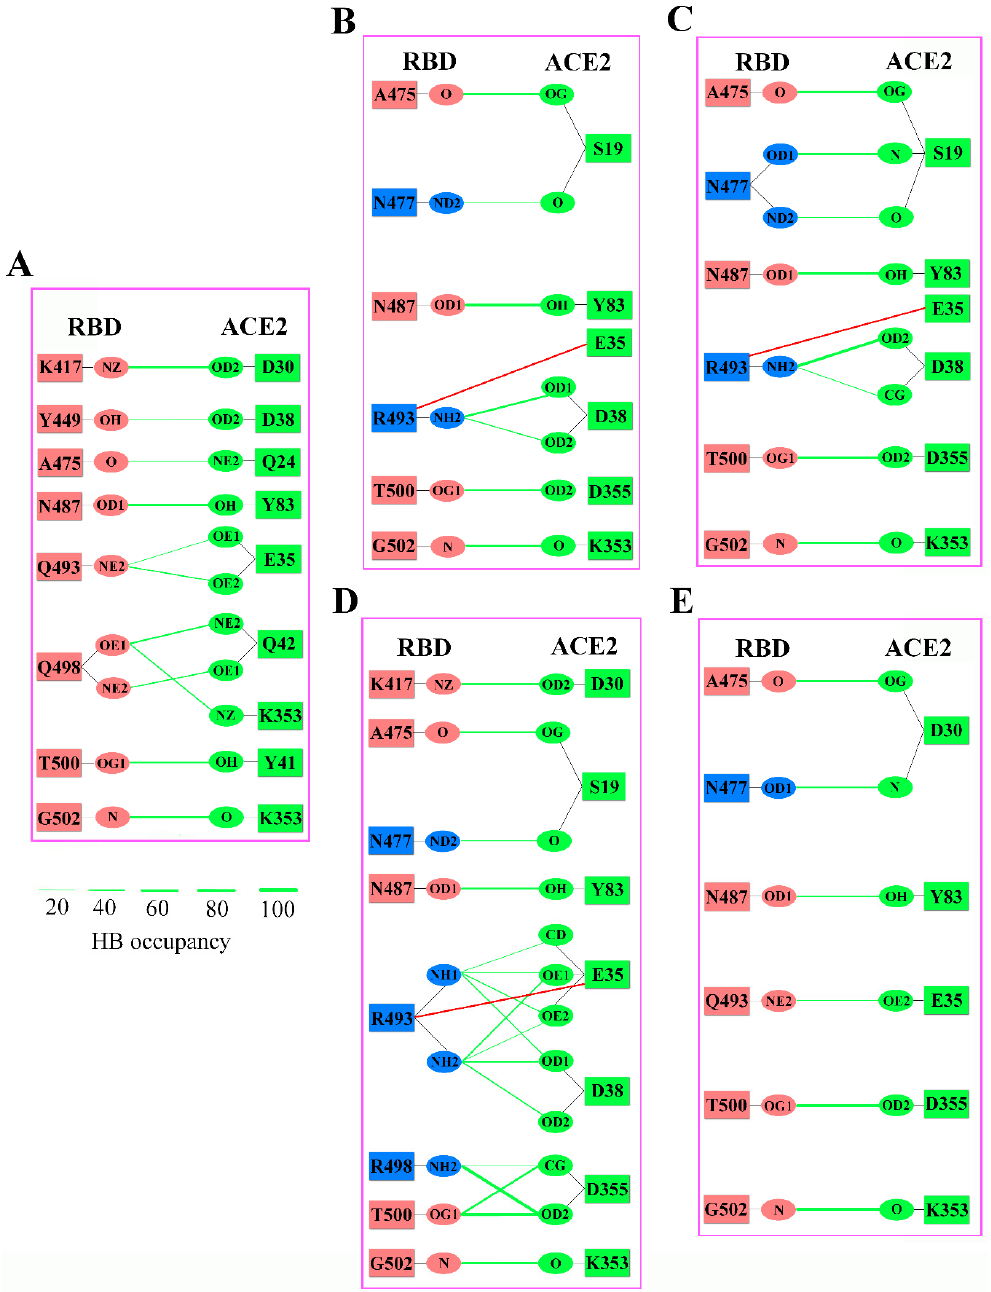
Figure 8. The hydrogen bond networks (HBNs) and salt bridges (SBs) across the binding interfaces of the RBD WT -ACE2 and RBD OMI s-ACE2 complexes. ( A ) RBD WT -ACE2. ( B ) RBD BA.1 -ACE2. ( C ) RBD BA.2 -ACE2. ( D ) RBD BA.3 -ACE2. ( E ) RBD BA.4/5 -ACE2. The RBD WT residues are colored in deep salmon, RBD mutated residues are colored in light blue, ACE2 residues are colored in green. The HBs with an occupancy greater than 20% are shown as green lines, SBs are represented as red lines, respectively.